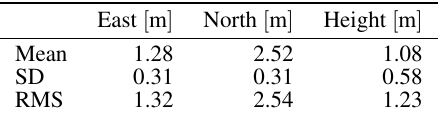
Table 5. Statistics of the differences between the image positions